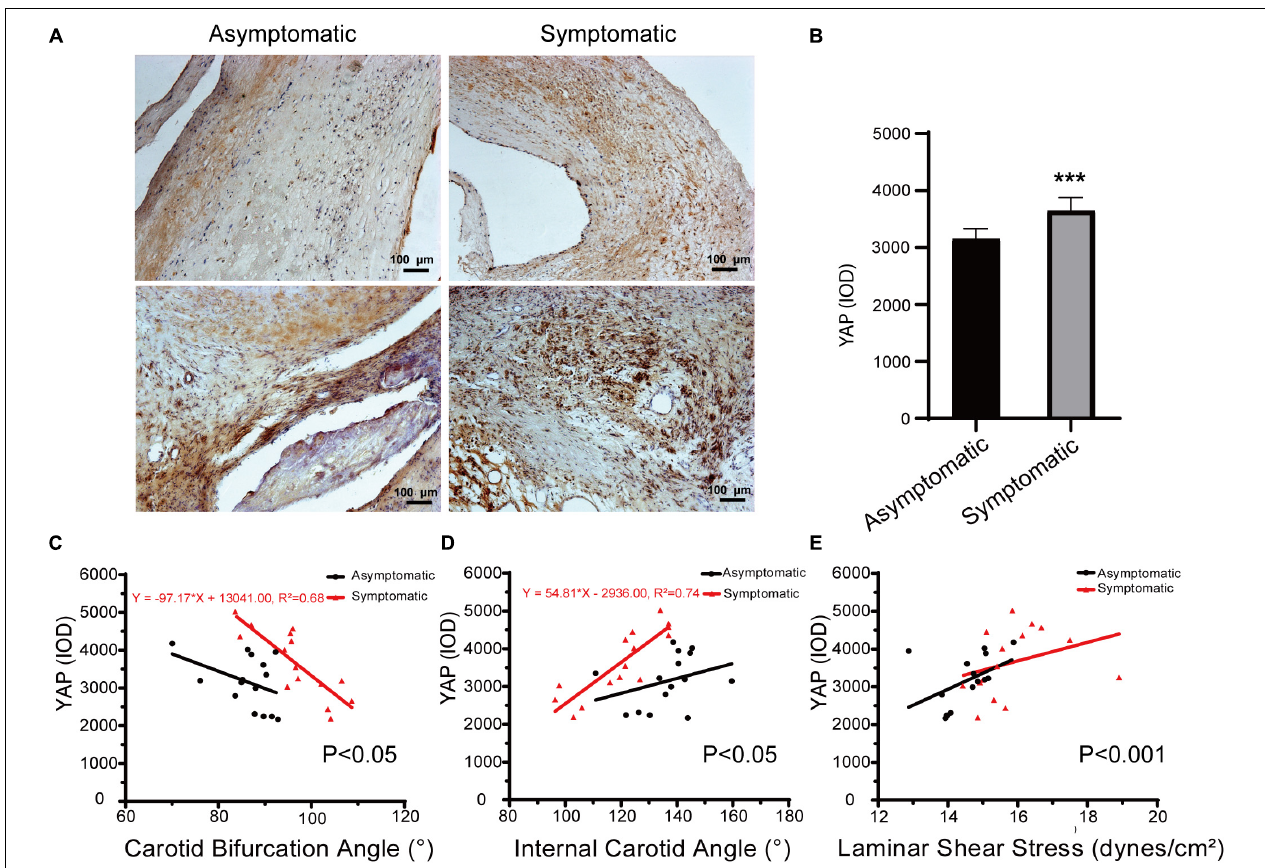
FIGURE 7 | Immunohistochemical staining of YAP in carotid atherosclerotic plaque. (A) Representative immunochemical results of yes-associated protein (YAP) expression in asymptomatic patients and symptomatic patients (bar = 100 µ m). (B) Quantification of IOD of YAP in asymptomatic patients and symptomatic patients. Error bars represent standard error of mean (SEM). *** P < 0.001. (C) Linear regression model of carotid bifurcation angle and YAP expression (asymptomatic: P > 0.05; symptomatic: P < 0.001, R 2 = 0.68); interaction between two groups had statistical significance ( P < 0.05). (D) Linear regression model of internal carotid angle and YAP expression (asymptomatic: P > 0.05; symptomatic: P < 0.001, R 2 = 0.74); interaction between two groups had statistical significance ( P < 0.05). (E) Linear regression model of laminar shear stress and YAP expression (asymptomatic: P > 0.05; symptomatic: P > 0.05); interaction between two groups had statistical significance ( P <